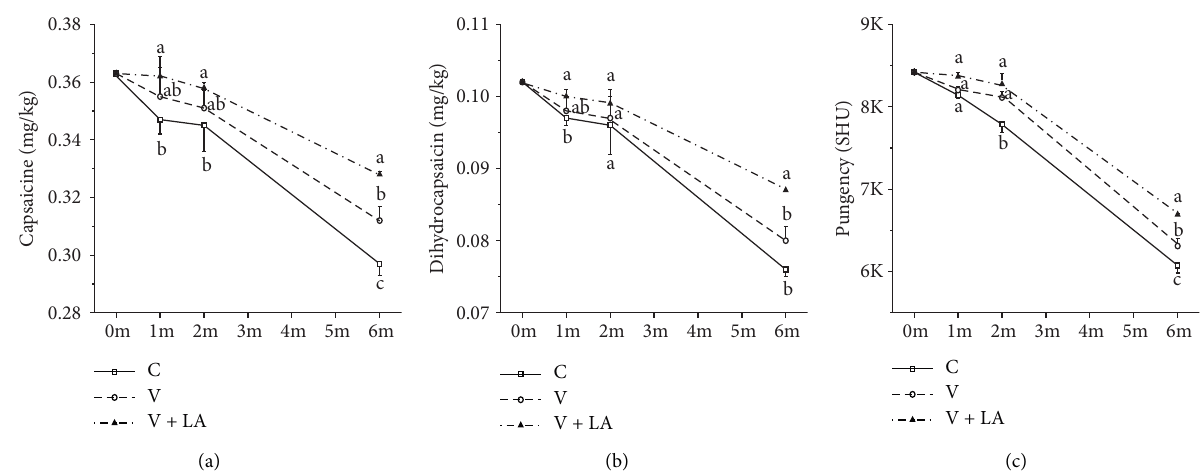
Figure 3: Efect of diferent packaging on capsaicin content, (a) dihydrocapsaicin content, (b) and pungency (c) of the dried peppers during storage. C: control with polyamide/polyethylene flm; V : vacuum packaging with polyamide/polyethylene flm; V +LA: vacuum and light- avoided packaging with aluminum polyethylene flm. SHU: Scoville Heat Unit. a–c represent the signifcant diference ( P < 0 . 05) of dried pepper stored in diferent packaging.